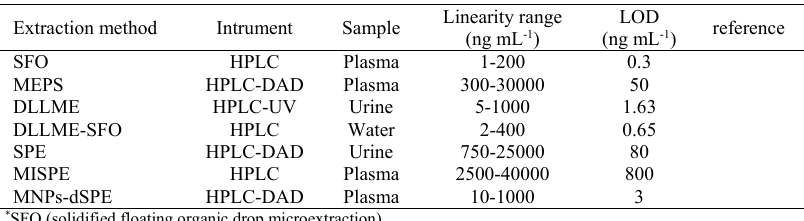
Table 5. comparison of the proposed method with other techniques in related studies